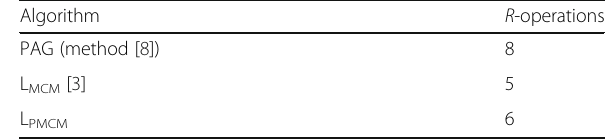
Table 6 Resulting R -operations for Example 4 using n = 2 input adders Algorithm